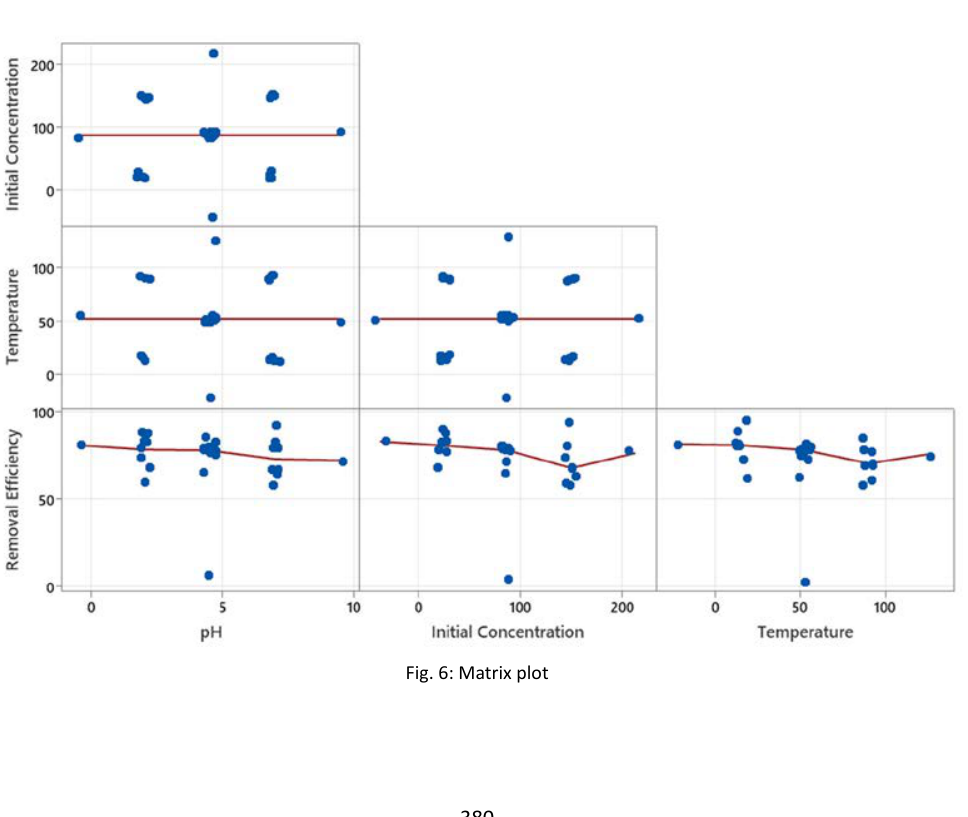
Fig. 6: Matrix plot